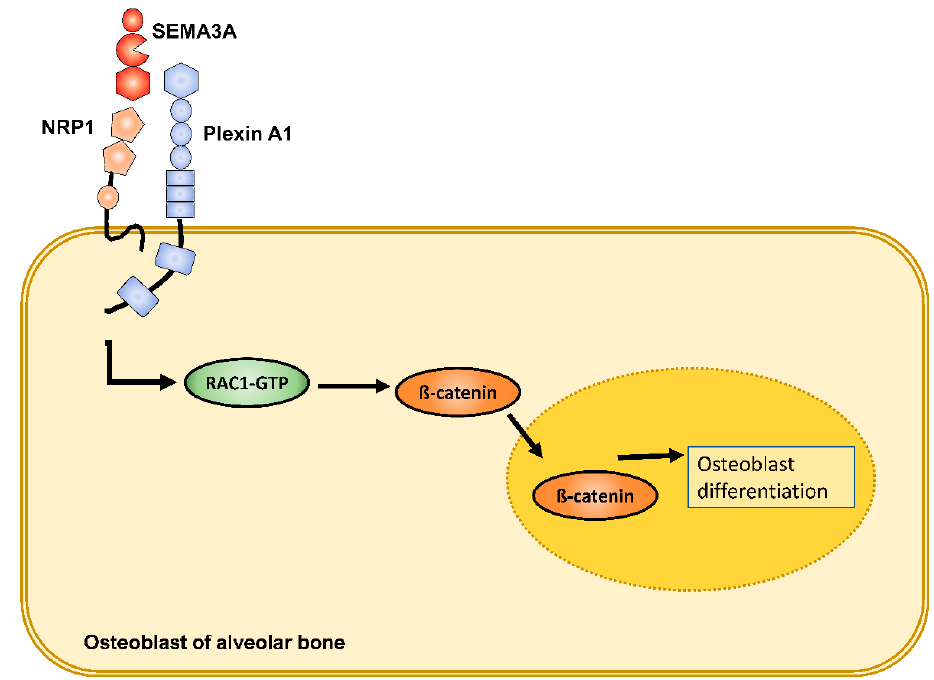
Figure 3. Exogenous Sema3A stimulation resulted in activation of Rac1 GTPase in osteoblasts of the alveolar bone. Sema3A caused transcriptional activation of β -catenin and its nuclear translocation accompanied by transcriptional induction of osteoblast differentiation via Runx2 and Osterix.